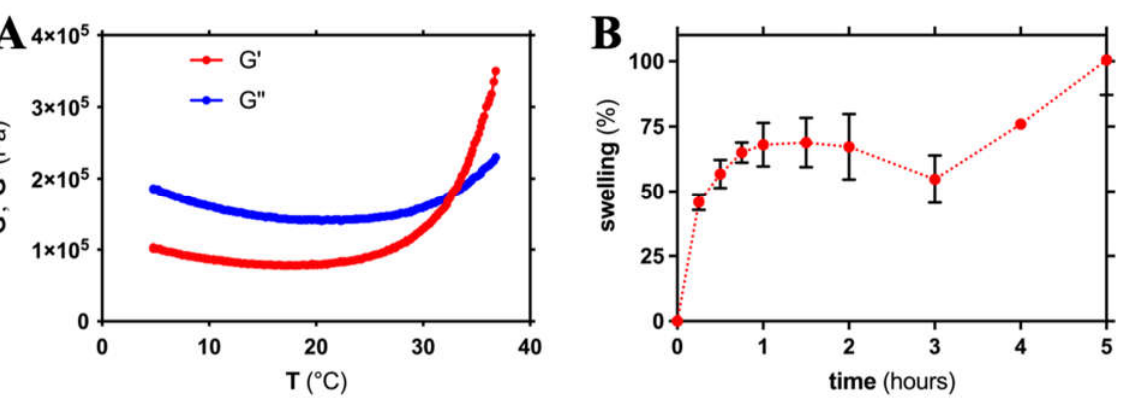
Figure 2. ( A ) Dependence of the elastic (G′) and viscous (G″) moduli on temperature for the mixture of chitosan and β-glycerophosphate. ( B ) Swelling behavior of hydrogel based on chitosan and β-glycerophosphate in PBS (pH = 7.4).